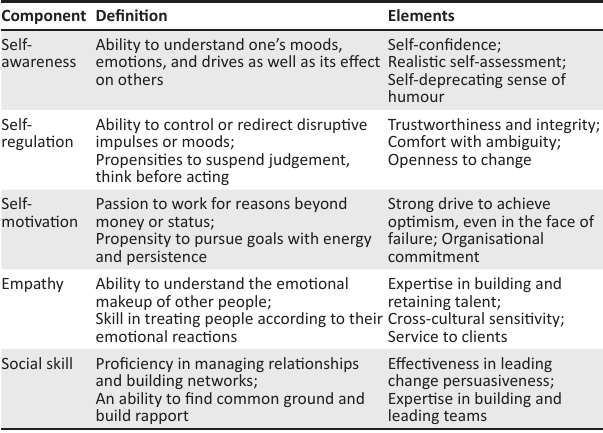
organisational success, hinges on the ability and intelligence TABLE 1: Components of emotional intelligence.